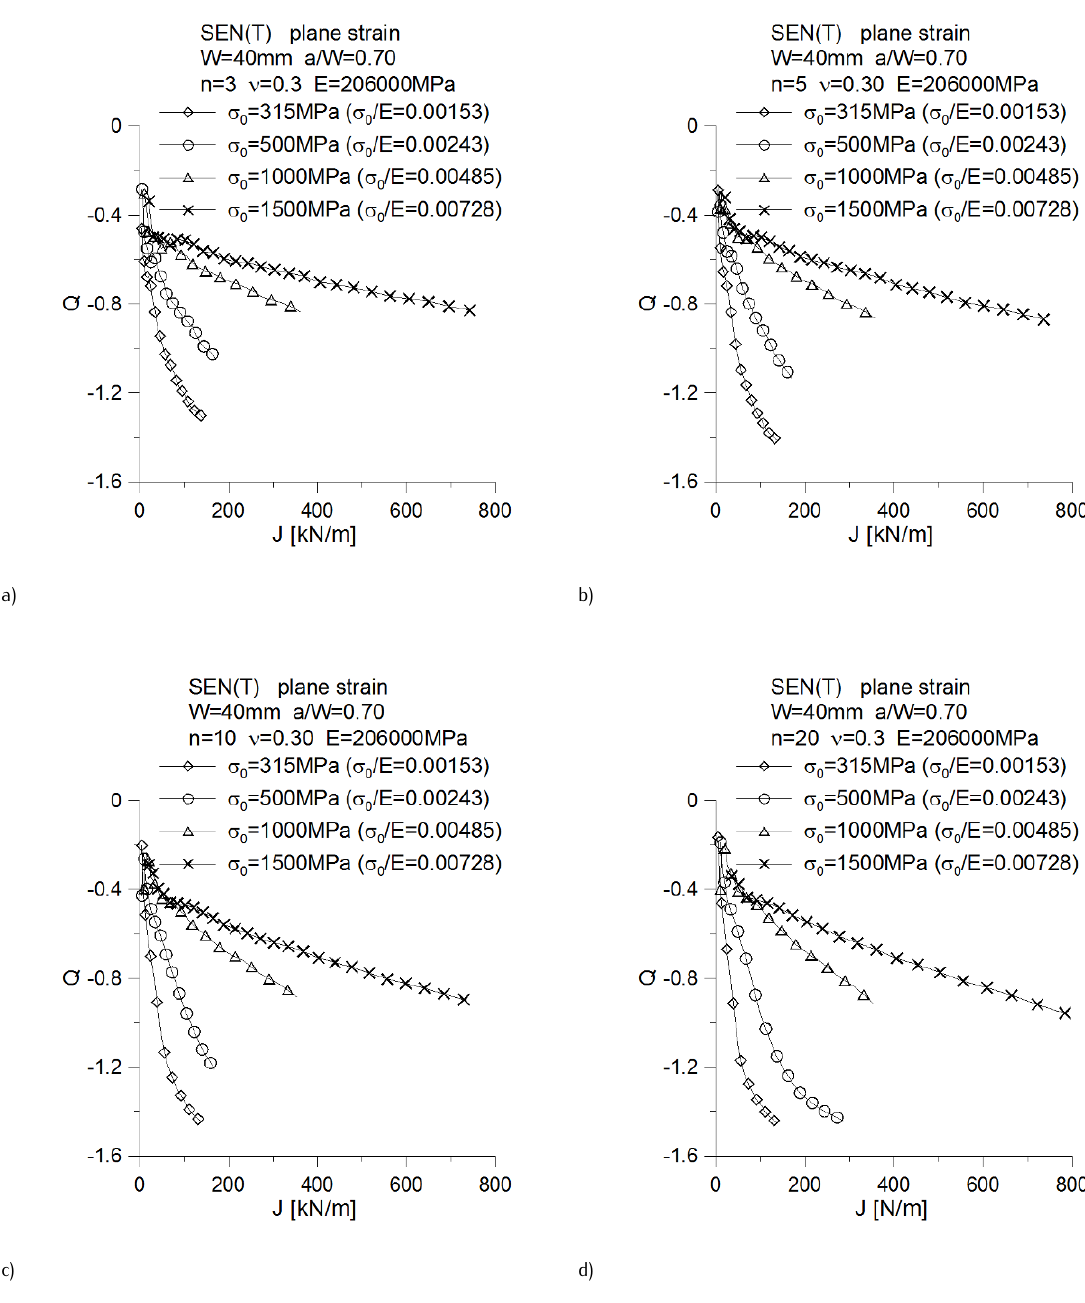
Figure 24. The influence of the yield stress on J - Q trajectories for SEN(T) specimens with crack length a / W =0.70 for different power exponents n in R-O relationship: a) n =3; b) n =5; c) n =10; d) n